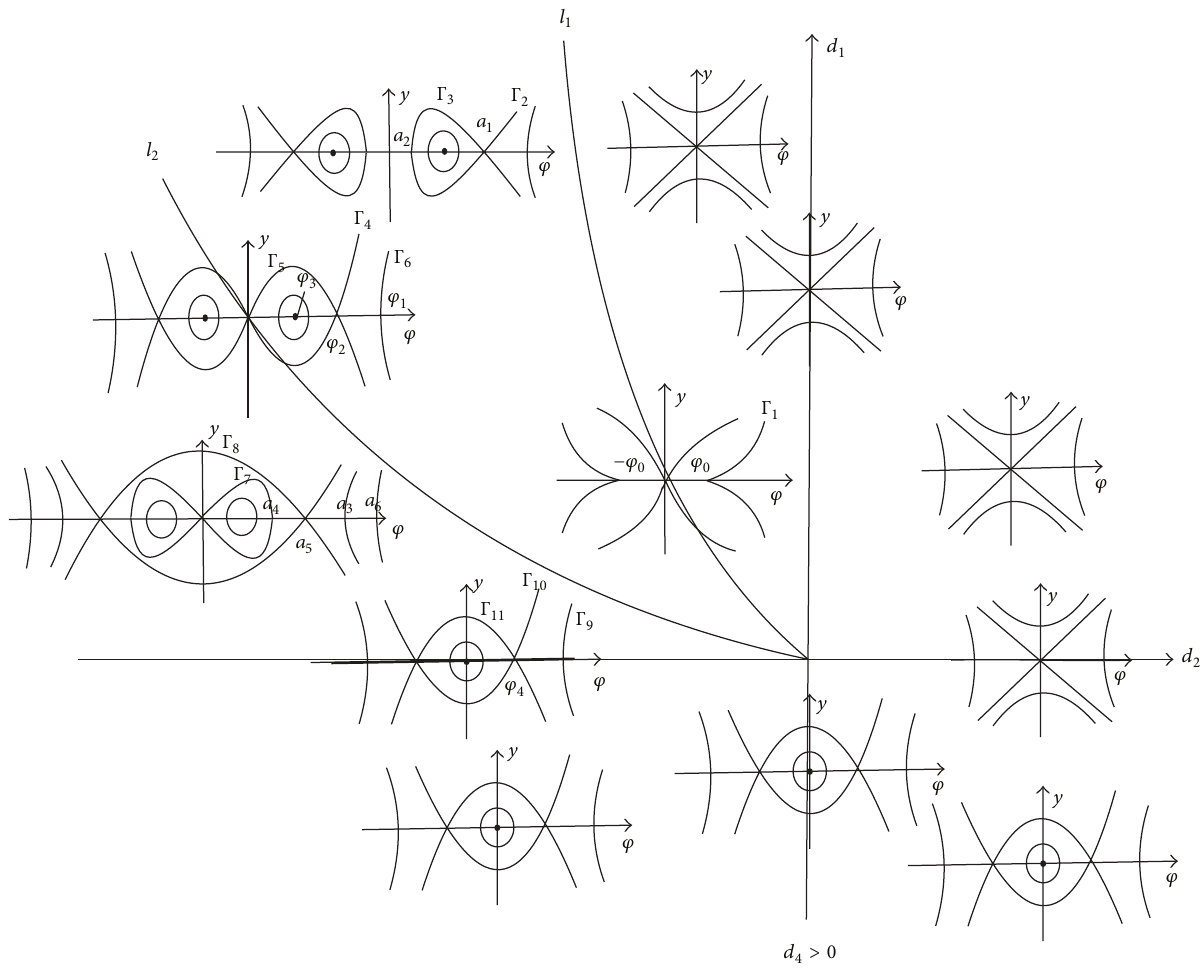
Figure 1: The phase portraits of system (12) when 𝑑 4 > 0